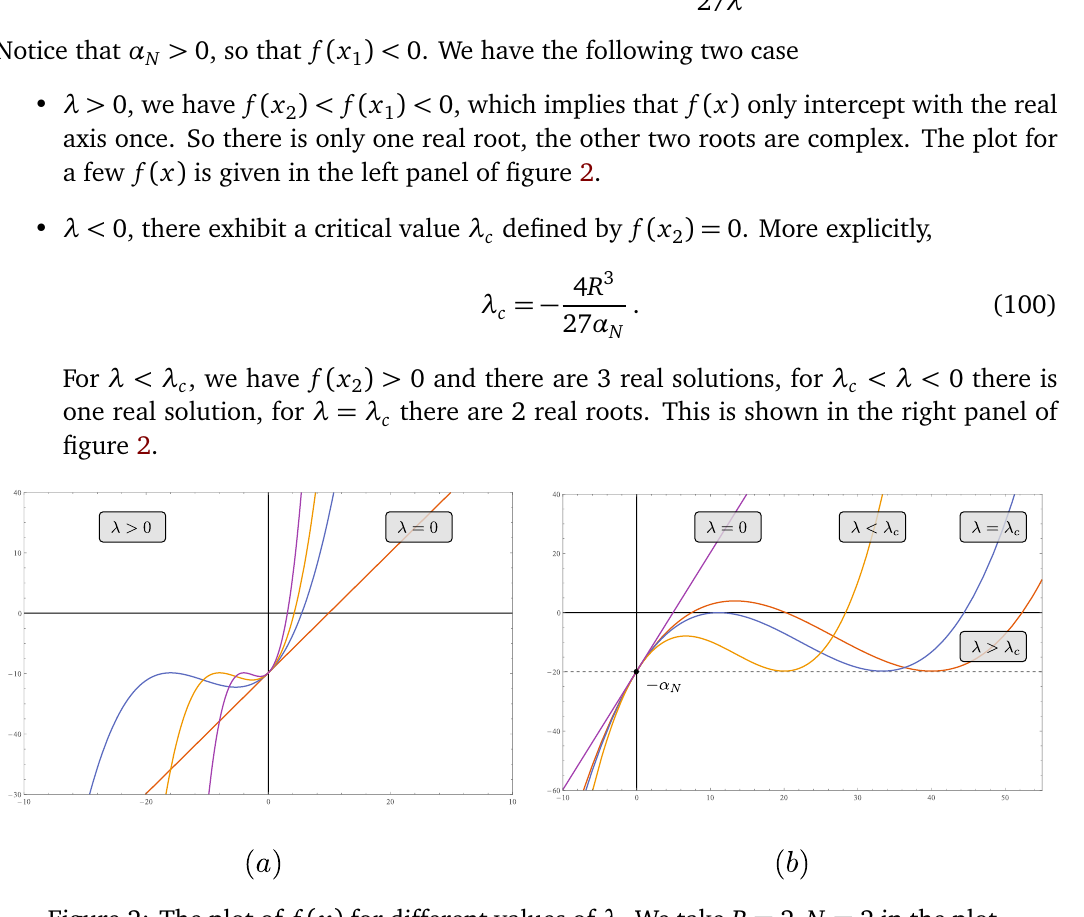
there is 1 real root, for c